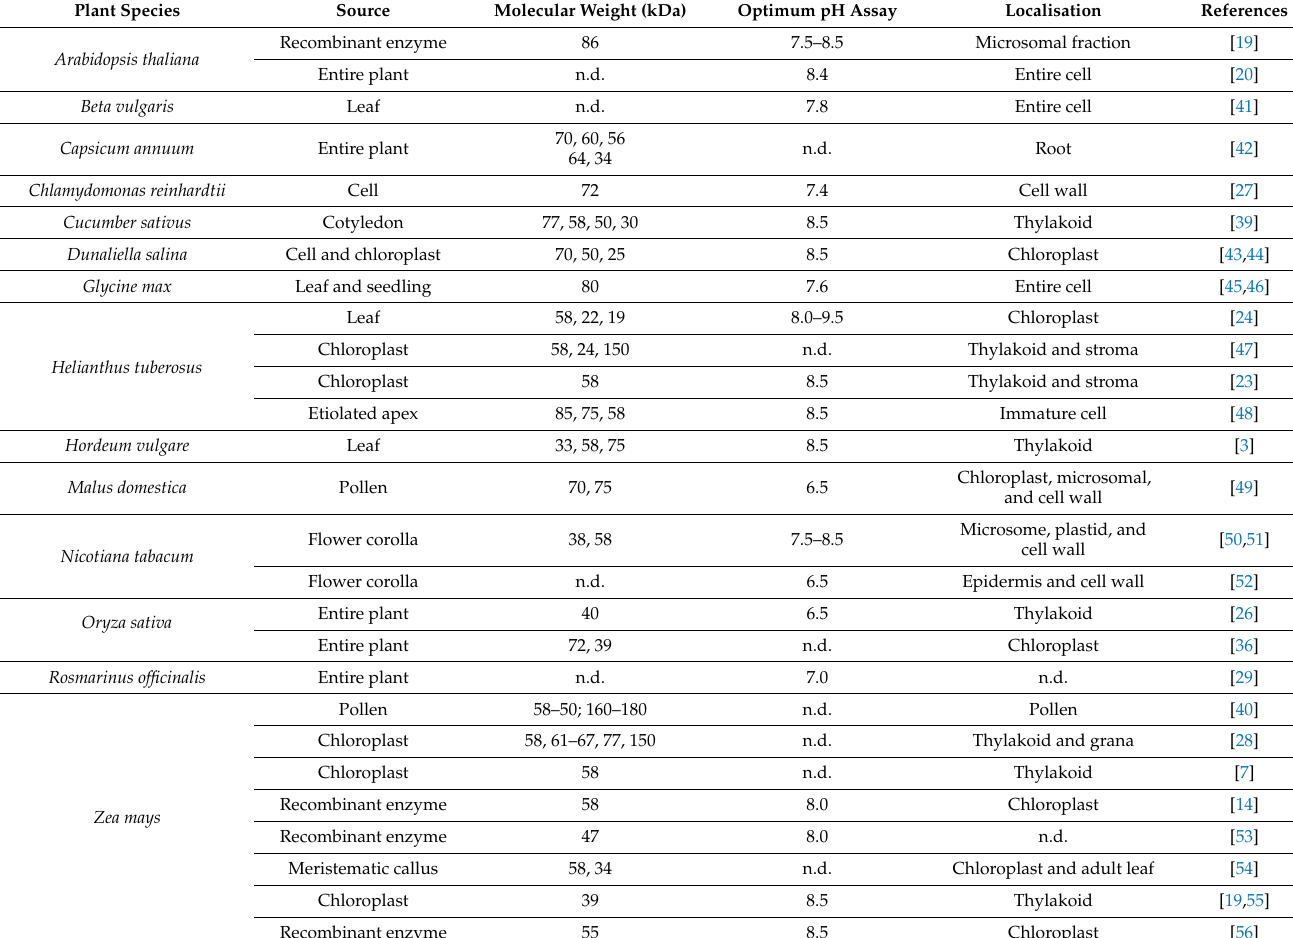
Table 1. Biochemical features of TGases in higher plants and algae. Plant species, source, molec- ular weight, optimum pH for activity assay, and localisation in cell compartments are reported; n.d.: not